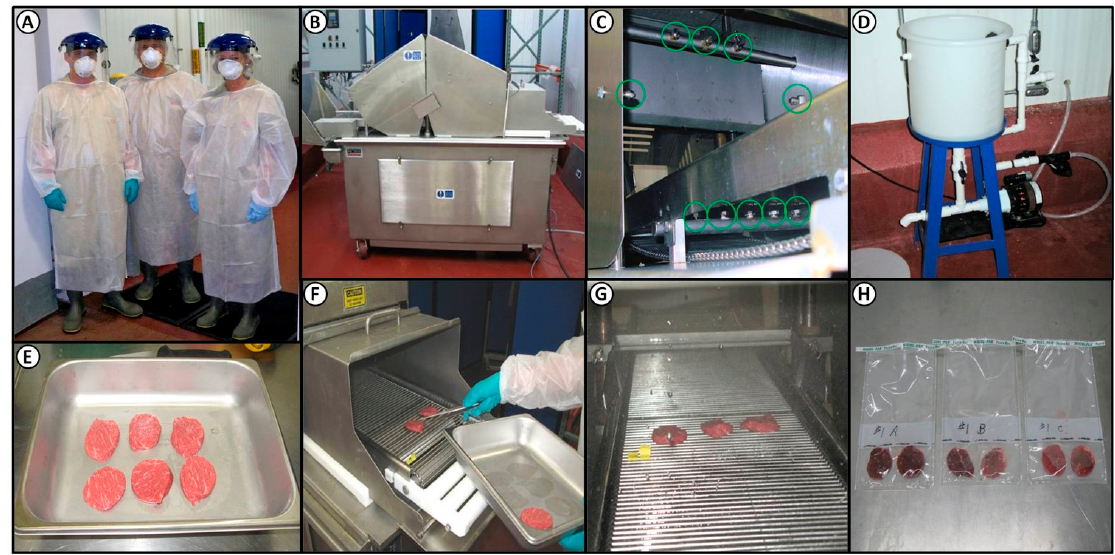
Figure 1. Phase 1, evaluating antimicrobial efficacy against Escherichia. coli O157:H7-inoculated lean beef discs. ( a ) BSL-2 lab personal protection equipment; ( b ) Ross blade tenderizer; ( c ) 10 spray nozzles (circled) integrated 360° into the entrance of the blade tenderizer; ( d ) solution reservoir and pump system in an adjacent room; ( e ) inoculated lean beef discs; ( f ) placement of inoculated discs on conveyor belt; ( g ) inoculated discs travelling through the 360° spray zone for 18 s dwell time; ( h ) processed beef discs are sampled in pairs prior to processing for microbial plating or vacuum-packaged for later analysis.